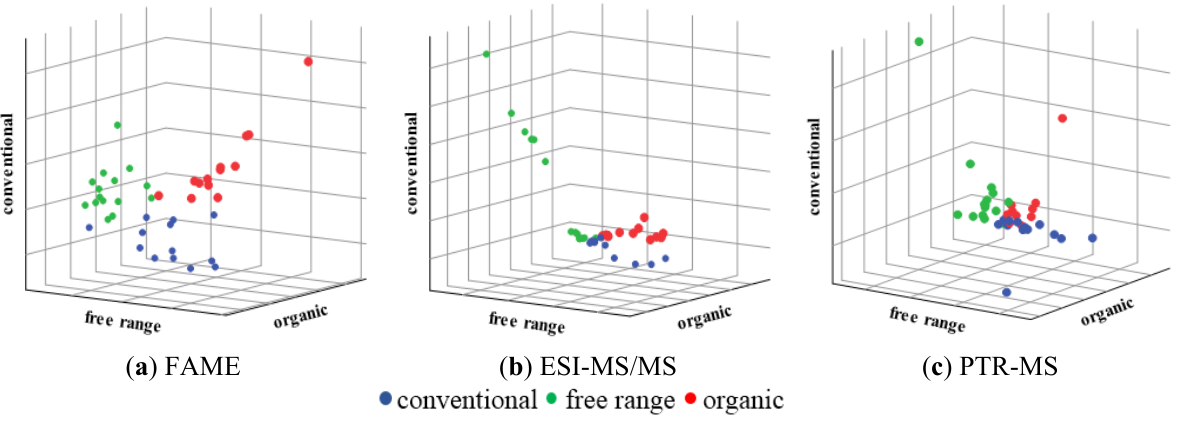
Figure 1. Graphical representation of sample distance to each class of the Soft Independent Modeling of Class Analogy (SIMCA) models for samples of pork belly meat from the categories conventional, free range, and